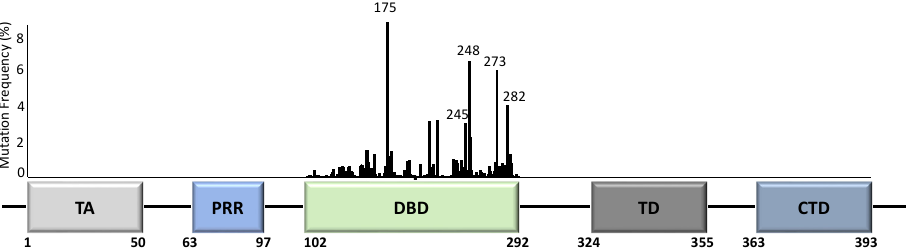
Figure 2. TP53 structure and mutation distribution (%) within the DNA-binding domain (DBD). The frequency of each mutation in all cancers based on the p53 database (www.p53.fr) is indicated for the DBD of TP53. Amino acid positions are indicated below the domains. Five TP53 hotspot mutation sites are further indicated with codon numbers above the bars. TA = transactivation domain; PRR = proline-rich region; DBD = DNA-binding domain; TD = tetramerization domain; CTD = carboxyl terminal regulatory domain.